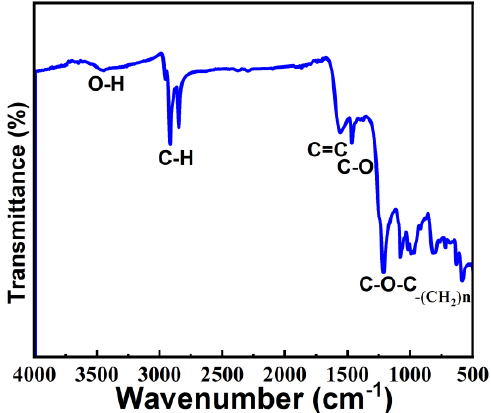
Figure 8. Infrared spectroscopy of rGO-SDS composite film .